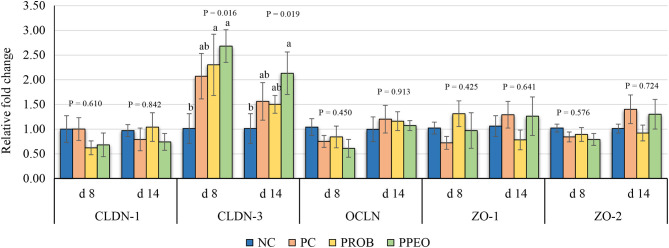
Relative mRNA abundance of tight junction proteins in the jejunum of broiler chickens on day (d) 8 and 14. Birds reared under a naturally occurring necrotic enteritis challenge model. Treatments include: NC (negative control): corn-soybean meal basal diet; PC (positive control): NC + 20 g virginiamycin (453 g Stafac®20)/ton diet; PROB (Probiotic): NC + B. licheniformis spores at the level of 227 g/ton diet; PPEO (probiotic/prebiotic/essential oil supplement): NC + 453 g/ton of a supplement containing B. licheniformis spores, mannan-oligosaccharides, β-glucans (1,3 and 1,6), capsaicin, and curcuma. Values are represented as a n-fold difference relative to the calibrator (NC). Results are given as means (n = 8) for each treatment. Error bars indicate standard errors. For each gene and sampling day, columns with different letters are significantly different (P < 0.05).